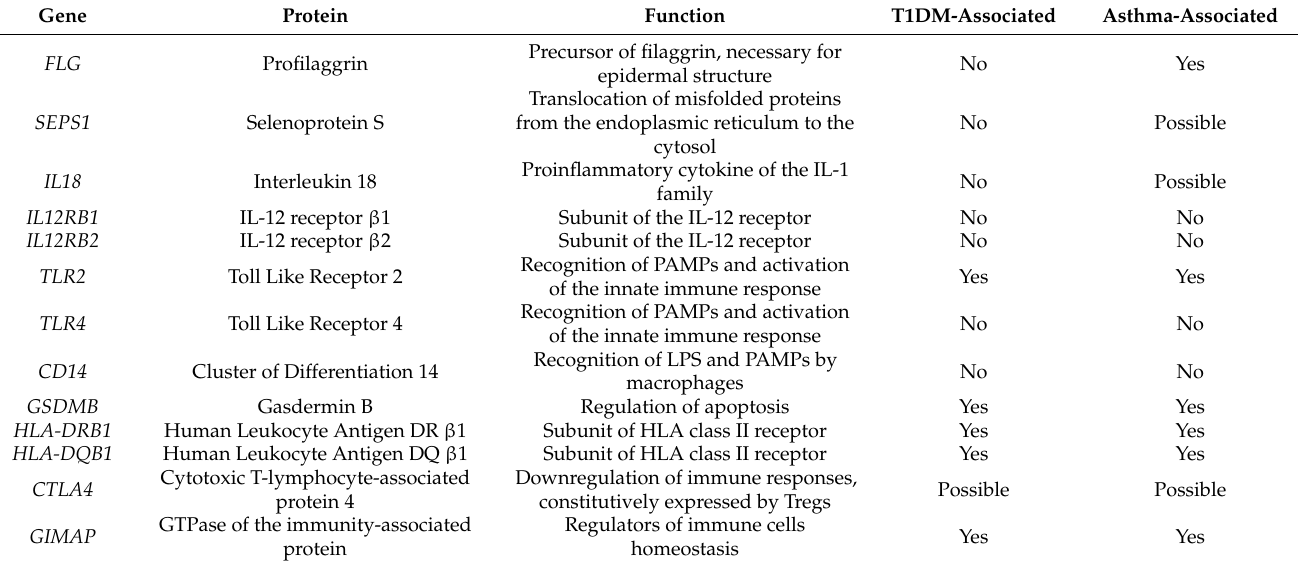
Table 1. Genes and relative molecular pathways involved in asthma and